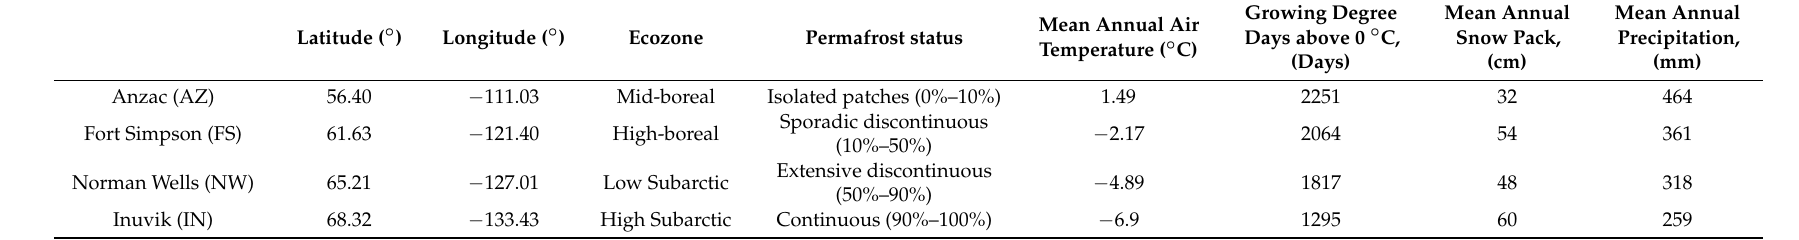
Table 1. Locations, ecozone permafrost status, and climatic description of the study